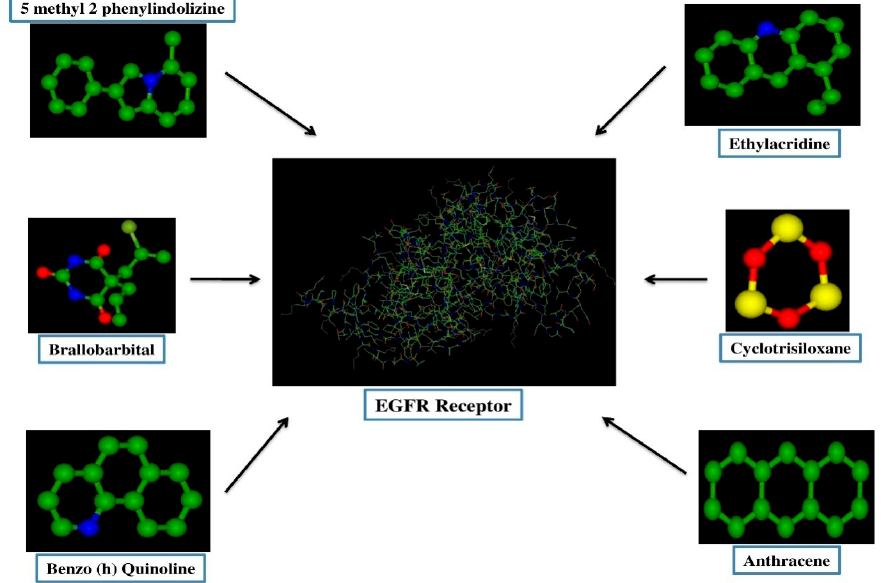
Figure 5. The 3D structural representation of small lung cancer receptor (EGFR) and various metabo- lites (ligands) identified through GC-MS from endophytic fungi, such as Cladosporium cladosporioides, Graminicolous helminthosporium , and Bipolaris australiensis.